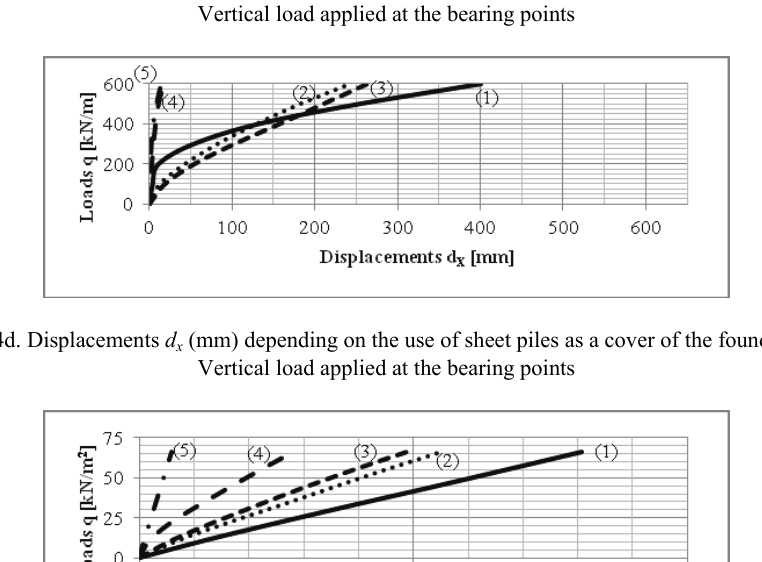
Fig. 4c. Displacements d 2 (mm) depending on the use of sheet piles as a cover of the foundation. Vertical load applied at the bearing points